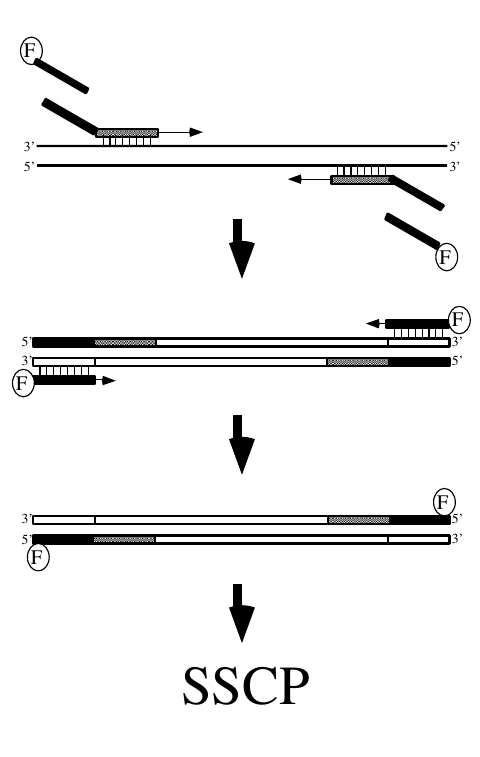
Figure 1 A schematic diagram of fluorescence-adapted SSCP method. F indicates a fluorescent dye (Cy-5). Shadowed boxes are specific primer sequences to amplify the IHRP gene, and black boxes are adapted sequences. These PCR reactions are performed in a single